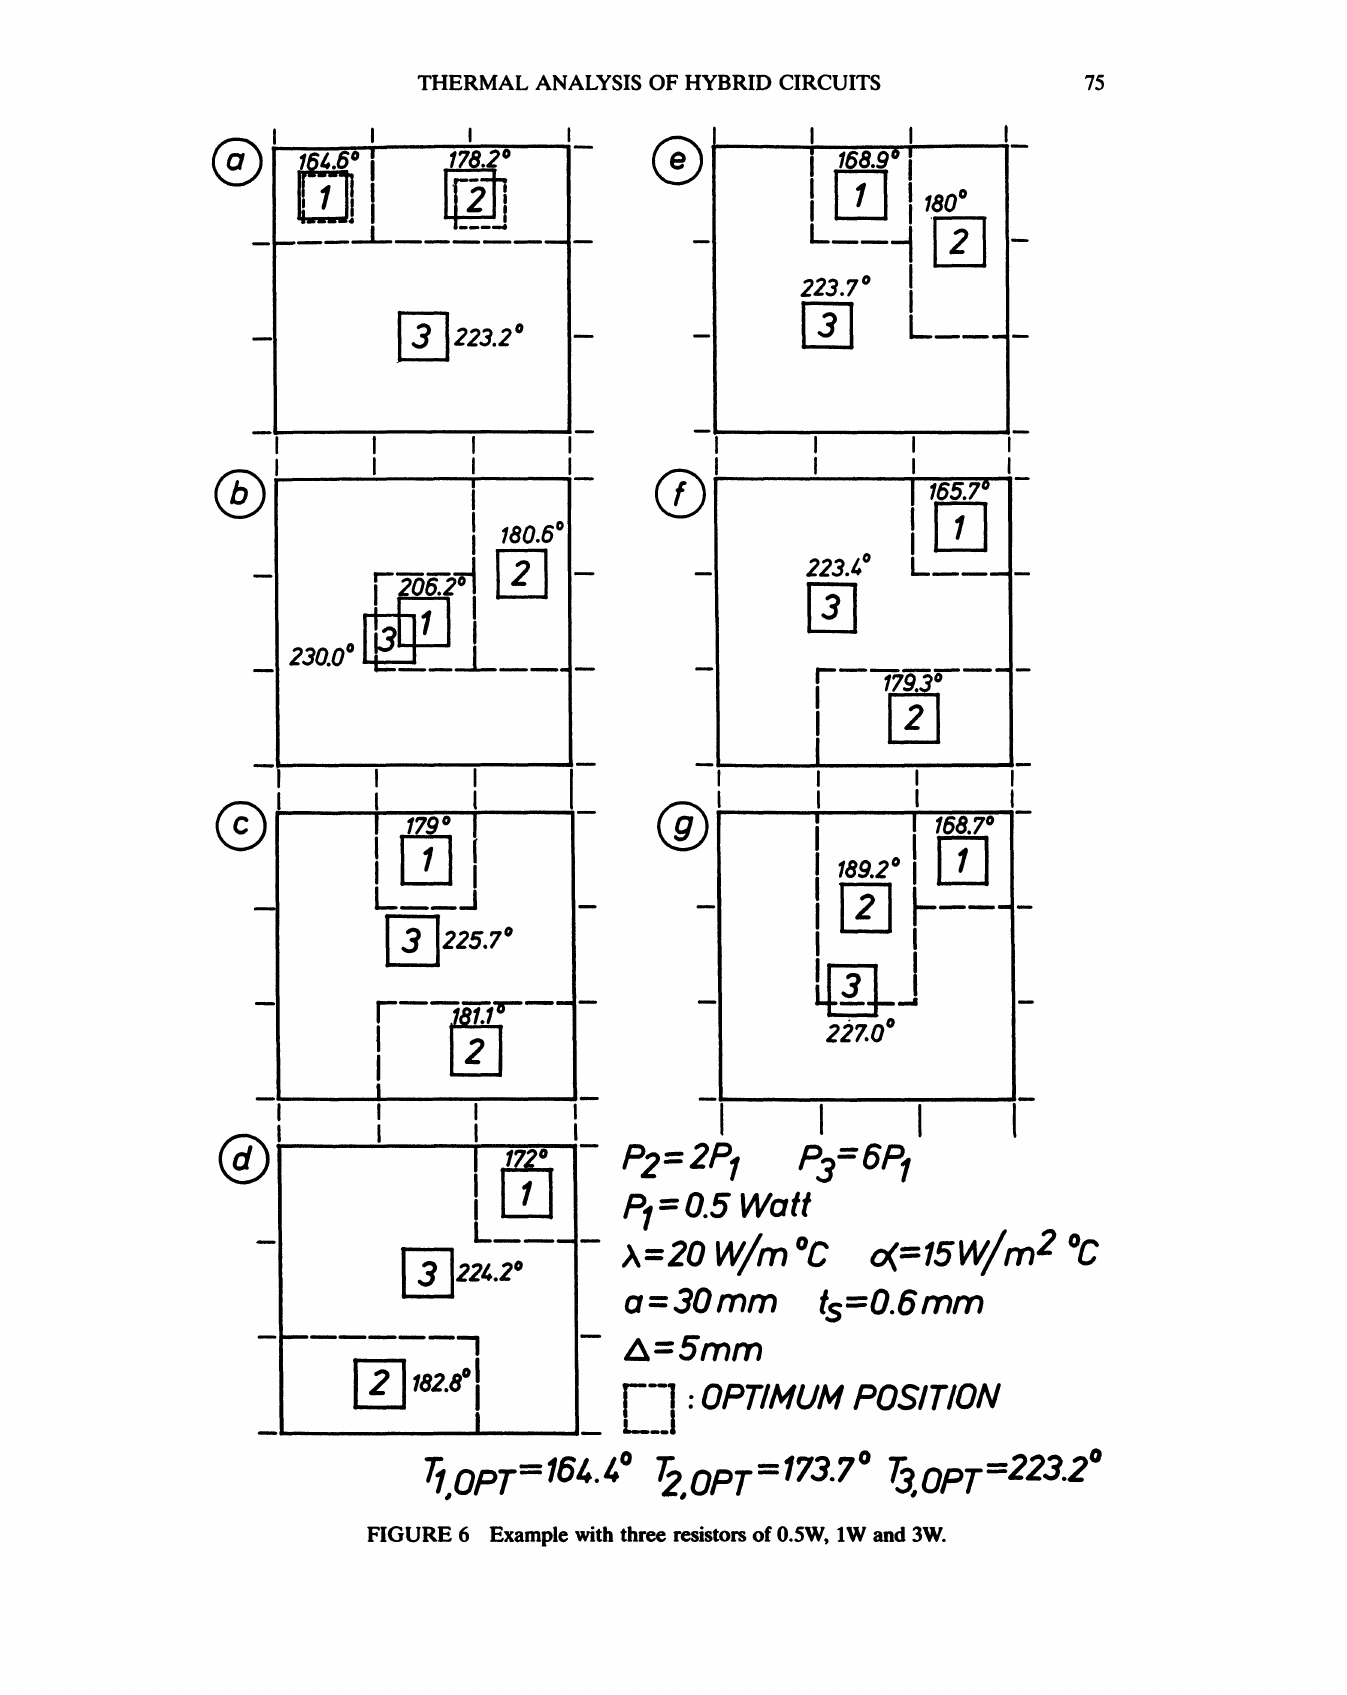
FIGURE 6 Example with three resistors of 0.5W, 1W and